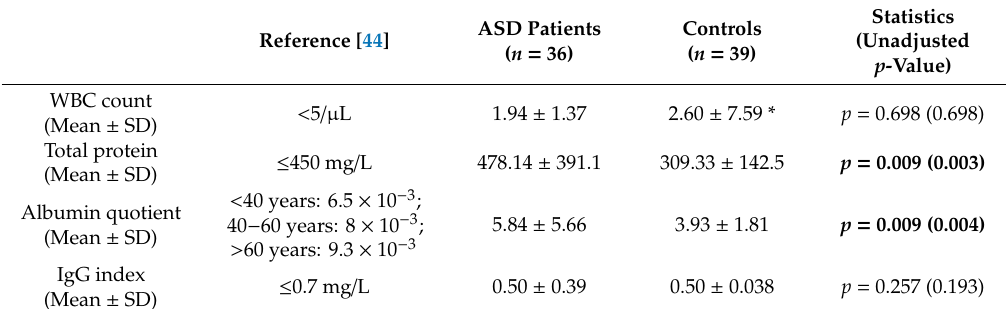
Table 3. CSF basis